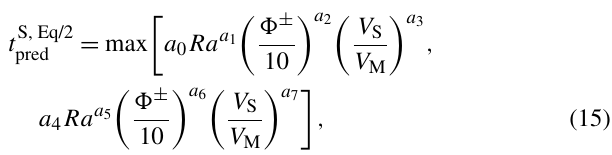
Figure 4. Snapshots of the FeO content in the solid mantle, X S , as a function of dimensionless time (factor of 10 − 6 inside each annulus) FeO for the cases presented in Fig. 3: (a) (cid:56) + = 10 − 1 , (b) (cid:56) + = 10 2 , and (c) (cid:56) + = 10 3 . In these simulations, the top magma ocean thickness is 500km and there is no basal magma ocean. Supercriticality is SC = 10 5 in all three cases shown. Snapshots within a red box indicate that the model time is close to the chemical half-equilibrium time, t S, Eq/2 . For (cid:56) + = 10 − 1 , 10 2 , and 10 3 , t S, Eq/2 = 9 . 6 × 10 − 6 , 114 . 9 × 10 − 6 , and 1895 . 5 × 10 − 6 respectively. Magenta contours correspond to the streamlines of the